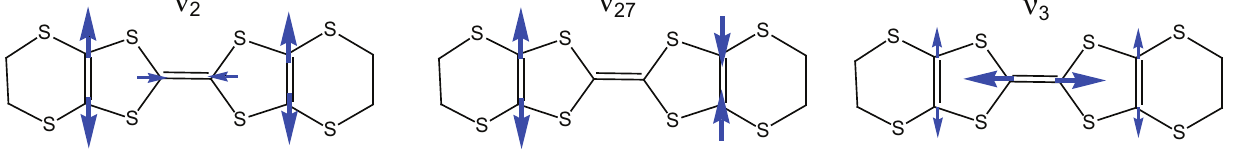
and ν modes are 2 27